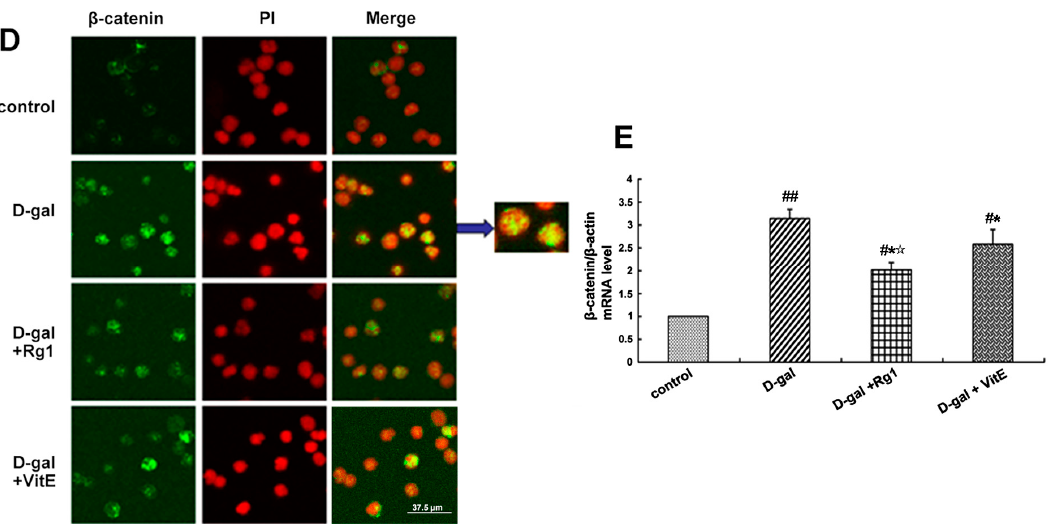
Figure 3. Effects of ginsenoside Rg1 on β -catenin expression of Sca-1 + HSC/HPCs from D -gal-induced aging mice. ( A ) The cytoplasmic and nuclear β -catenin is shown by Western blot. β -actin was used as the internal control for the cytoplasmic proteins, whereas histone 2A was the internal control for the nuclear proteins; ( B , C ) Quantification of cytoplasmic and nuclear β -catenin protein levels is shown. In the D -gal model group, the expressions of cytoplasmic and nuclear β -catenin were increased compared to the other three groups; ( D ) Immunofluorescence staining of β -catenin is shown. There was an obvious increase in fluorescent protein in the cell nucleus of the D -gal model group. Green indicates β -catenin mAb. Red indicates nuclei stained by PI. Scale bar = 37.5 µ m; ( E ) The mRNA expression of β -catenin was assessed by real-time quantitative RT-PCR, in which β -actin was used as an internal control (mean ± SD, n =3; # p < 0.05, ## p < 0.01 vs. the control group, * p < 0.05 vs. the D -gal model group, ☆ p < 0.05 vs. the D -gal + VitE group).